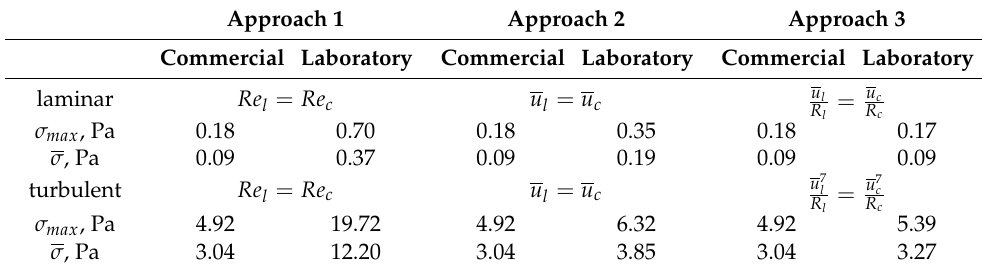
Table 2. Comparison between the tested approaches under laminar and turbulent flow in terms of maximum shear stress ( σ max , Pa) and effective average shear stress ( σ , Pa) between commercial and laboratory